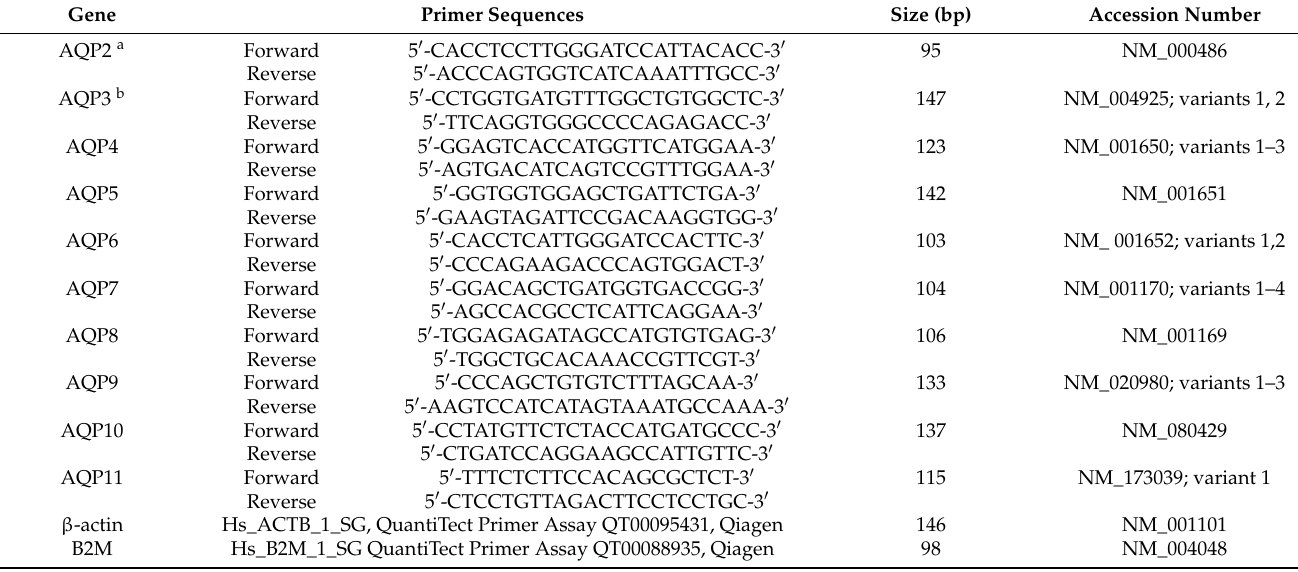
Table 1. Primer sequences used for real-time reverse transcription/polymerase chain